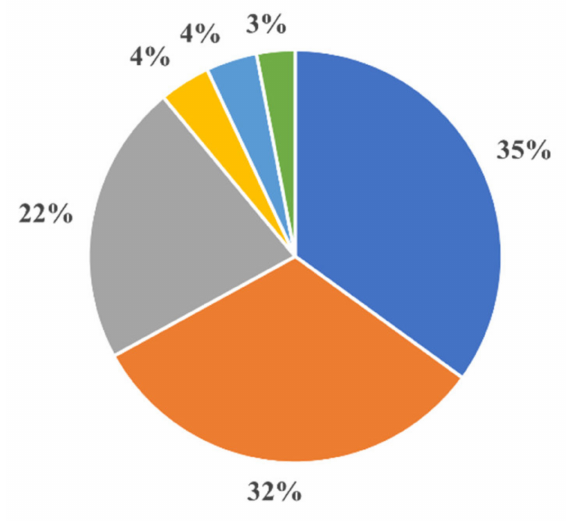
Figure 3. Timeline of Seongdaegol Living Lab.